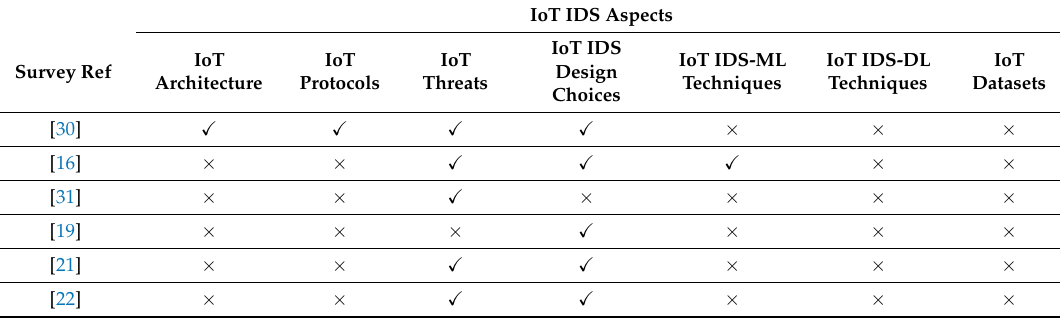
Table 1. A comparison of this survey with others in terms of developing IoT-based Intrusion Detection Systems